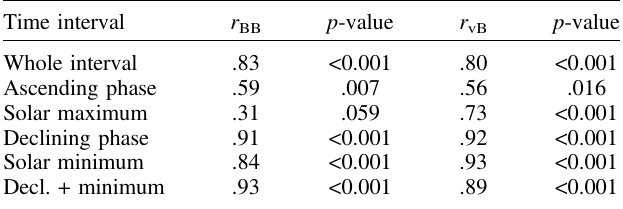
Table 2. Correlation coef fi cients between ground pulsation power and solar wind magnetic ( r BB ) and solar wind speed fl